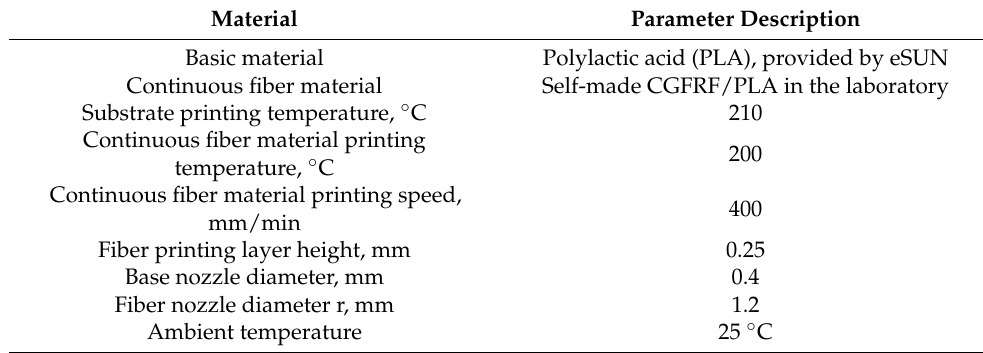
Table 3. Printing parameters.